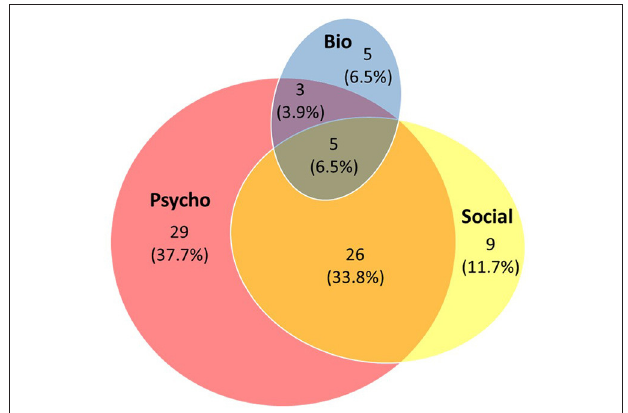
TABLE 1 | Programs covering biological, psychological, and social components by target student